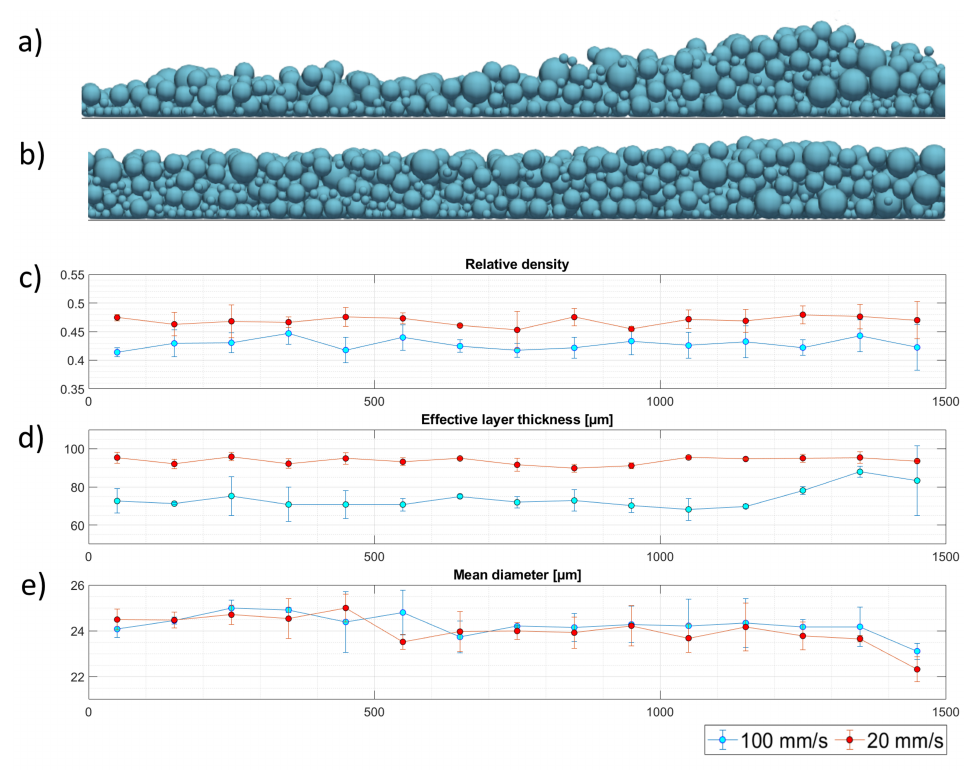
Figure 8. Typical state of the powder bed after the spreading process at ( a ) 100mm/s and ( b ) 20mm/s. ( c ) Relative density, ( d ) effective thickness, and ( e ) mean diameter of the layer of powder along the spreading